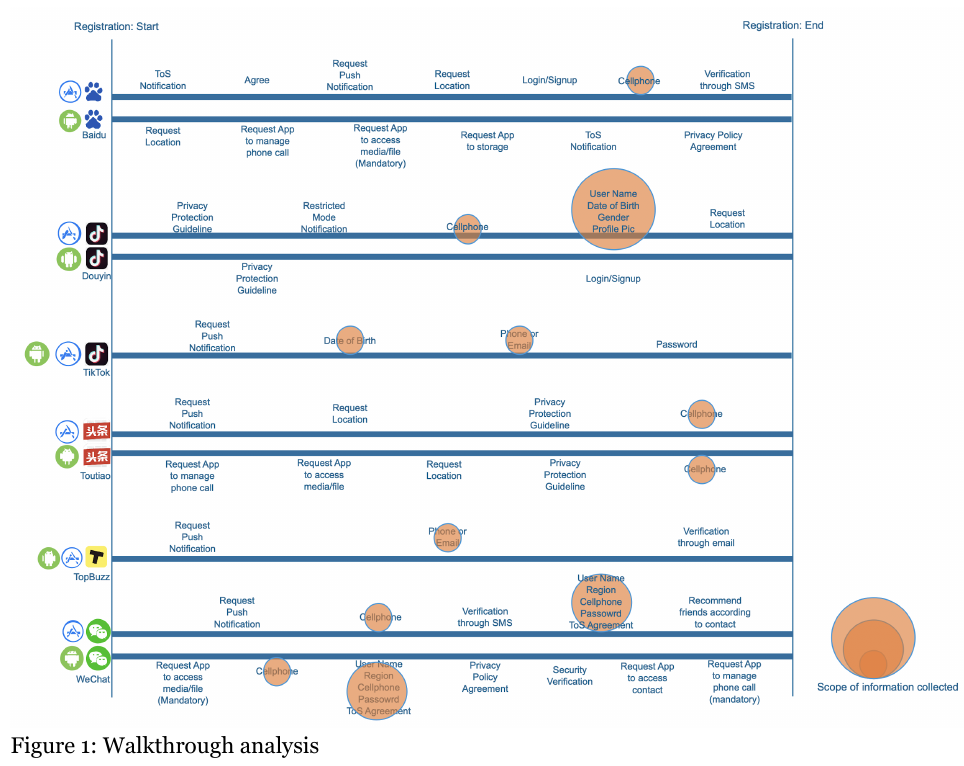
Figure 1: Walkthrough